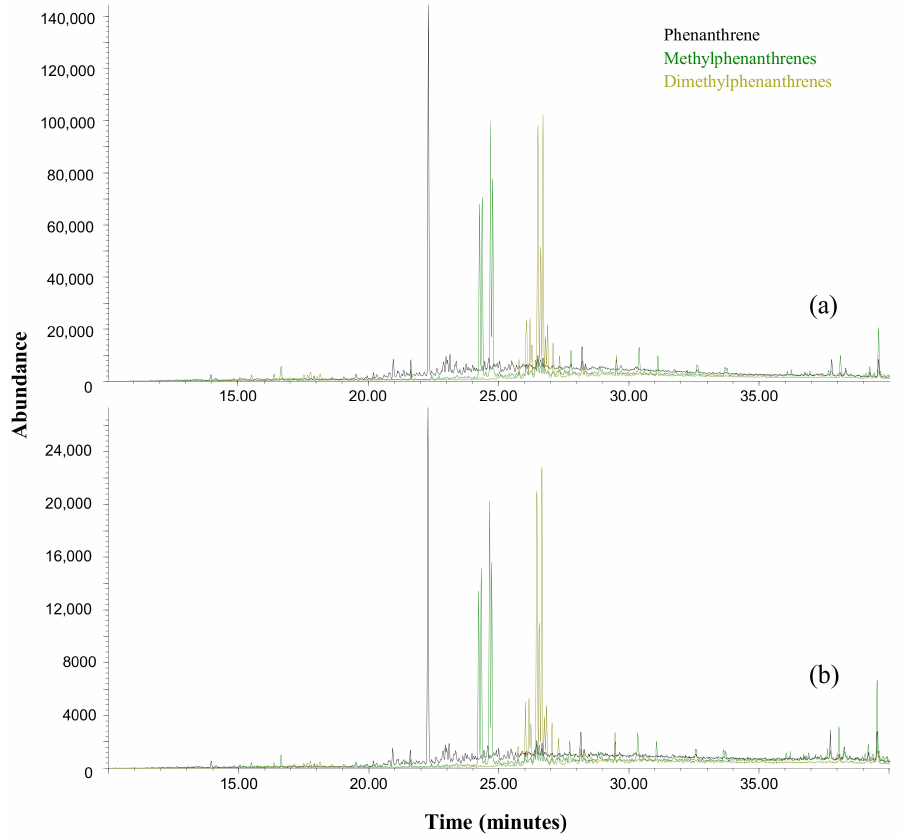
Figure 8. Chromatographic fingerprints of m / z 178, m / z 192, and m / z 206 of ( a ) remaining oil after 120 h in the abiotic test and ( b ) remaining oil after 120 h of Y. lipolytica ’s growth in seawater with 1% v / v of